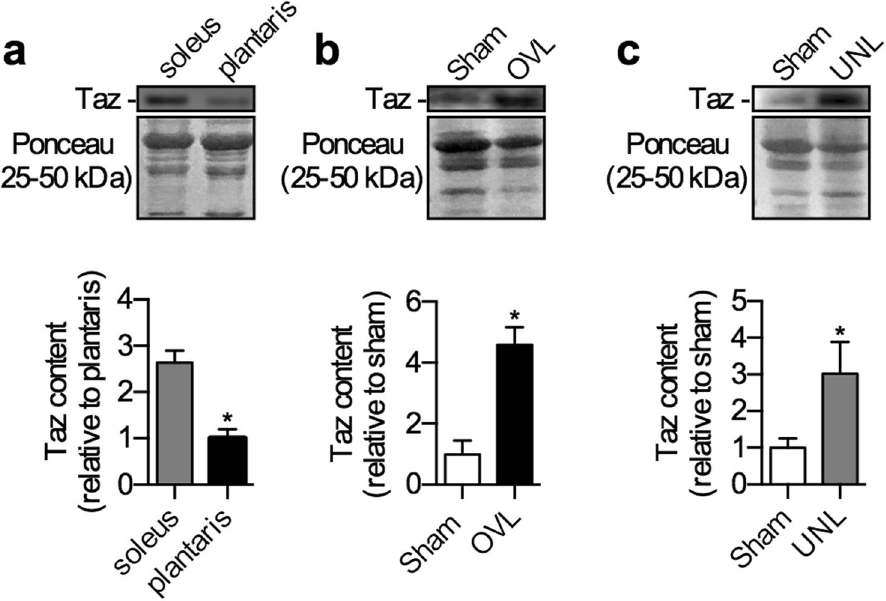
Figure 5. Taz protein expression is higher in the soleus compared with plantaris and is upregulated in response to both overload (OVL) and unload (UNL) stimuli. ( a ) Taz protein expression (~27 kDa) in the sham plantaris and soleus muscles. ( b ) Taz protein in the OVL plantaris compared with sham. ( c ) Taz protein in the UNL soleus compared with sham. * p ≤ 0.05 using a Student’s t-test ( a , two-tailed) or paired t-test ( b and c , two- tailed), n = 6 per group. Please refer to Fig. S4 for full length Western